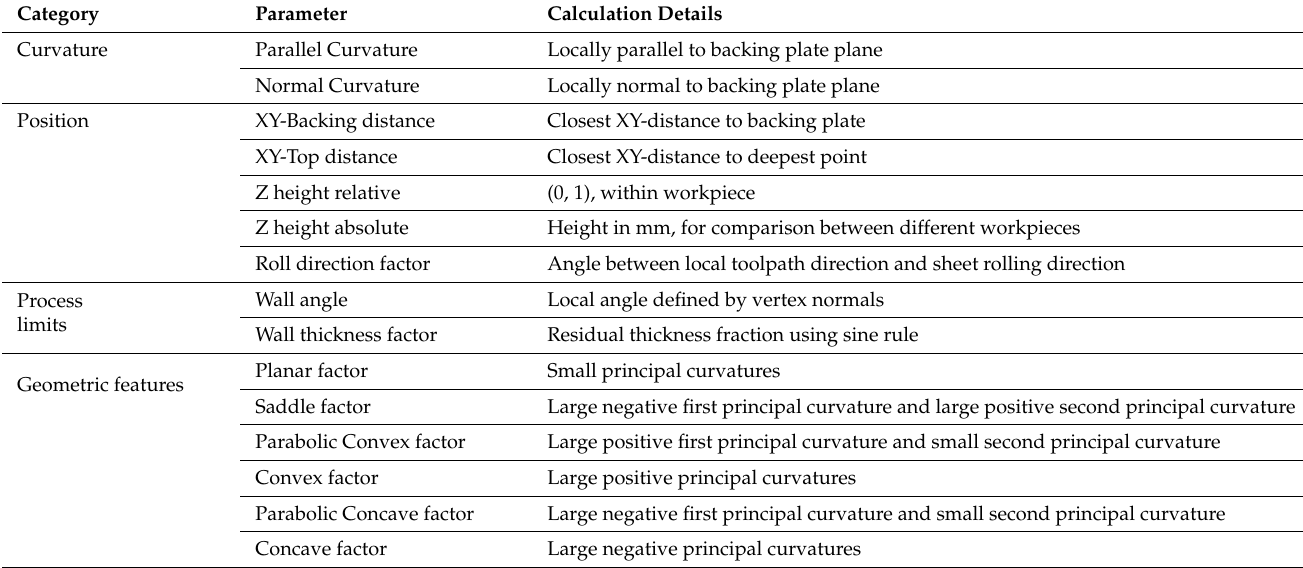
Table 1. Vertex-based geometric